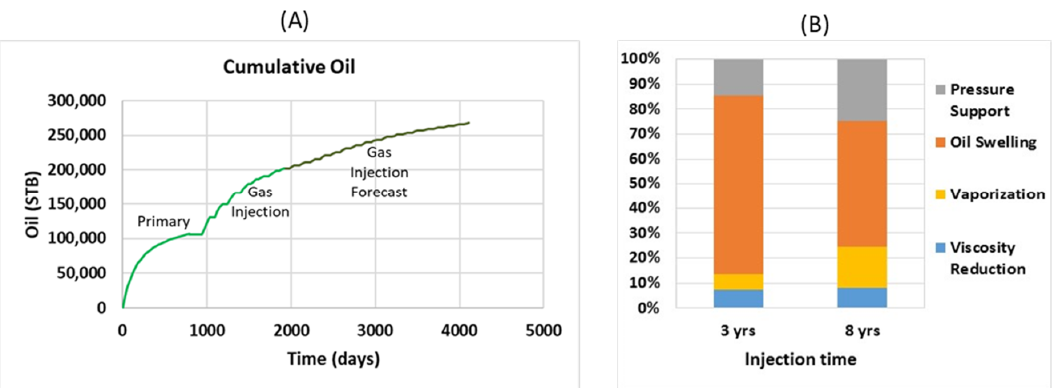
Figure 24. ( A ) Cumulative oil recovery when gas injection process is extended for 5 additional years (8 years total), and ( B ) relative importance of different recovery mechanisms.